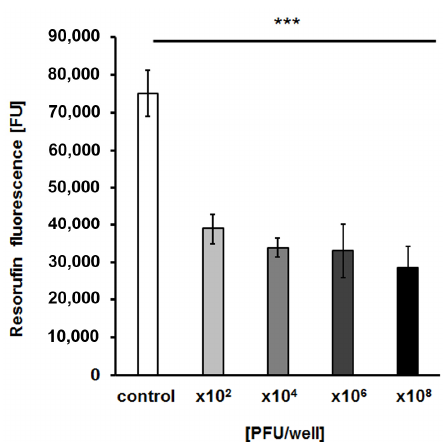
Figure 9. Metabolic activity / viability of bacterial cells in the biofilm after infection with phage vB_EfaS-271 estimated by the resazurin assay. Phage lysate was added to final titers of 10 2 , 10 4 , 10 6 or 10 8 PFU / well and incubated with the bacteria in the biofilm for 24 h. The results are presented as the mean values ± SD from three independent experiments. Statistical analyses were performed by t- test. Significant ( p < 0.001) differences between the control without phage infection and particular variants of vB_EfaS-271 infection are marked by asterisks (***).